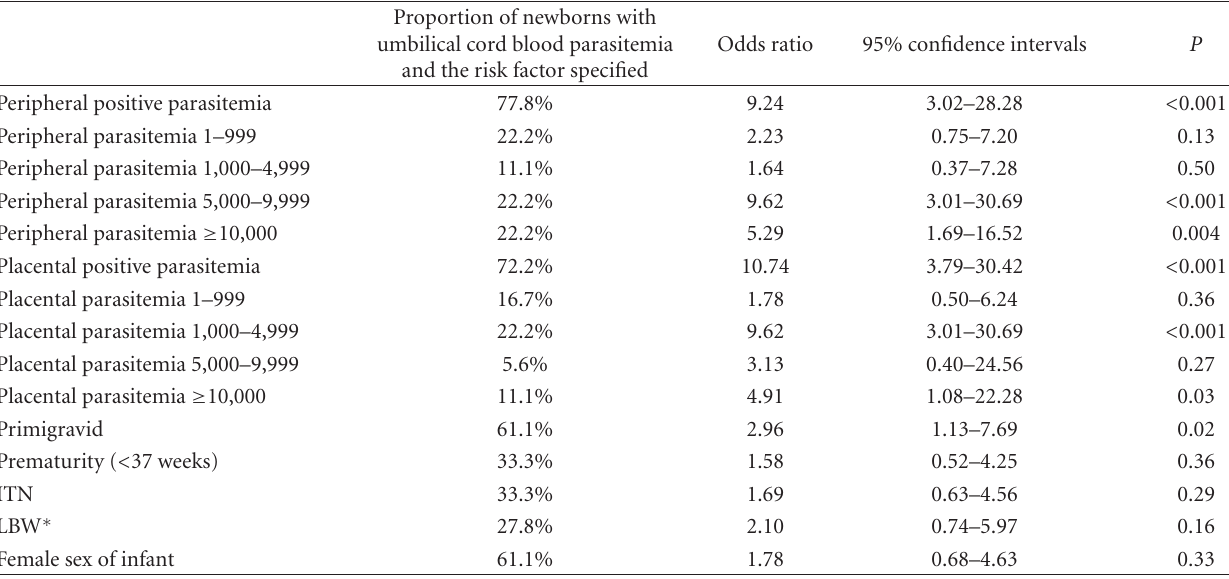
Table 3: Univariate logistic regression of risk factors associated with Plasmodium falciparum parasitemia in umbilical cord blood.